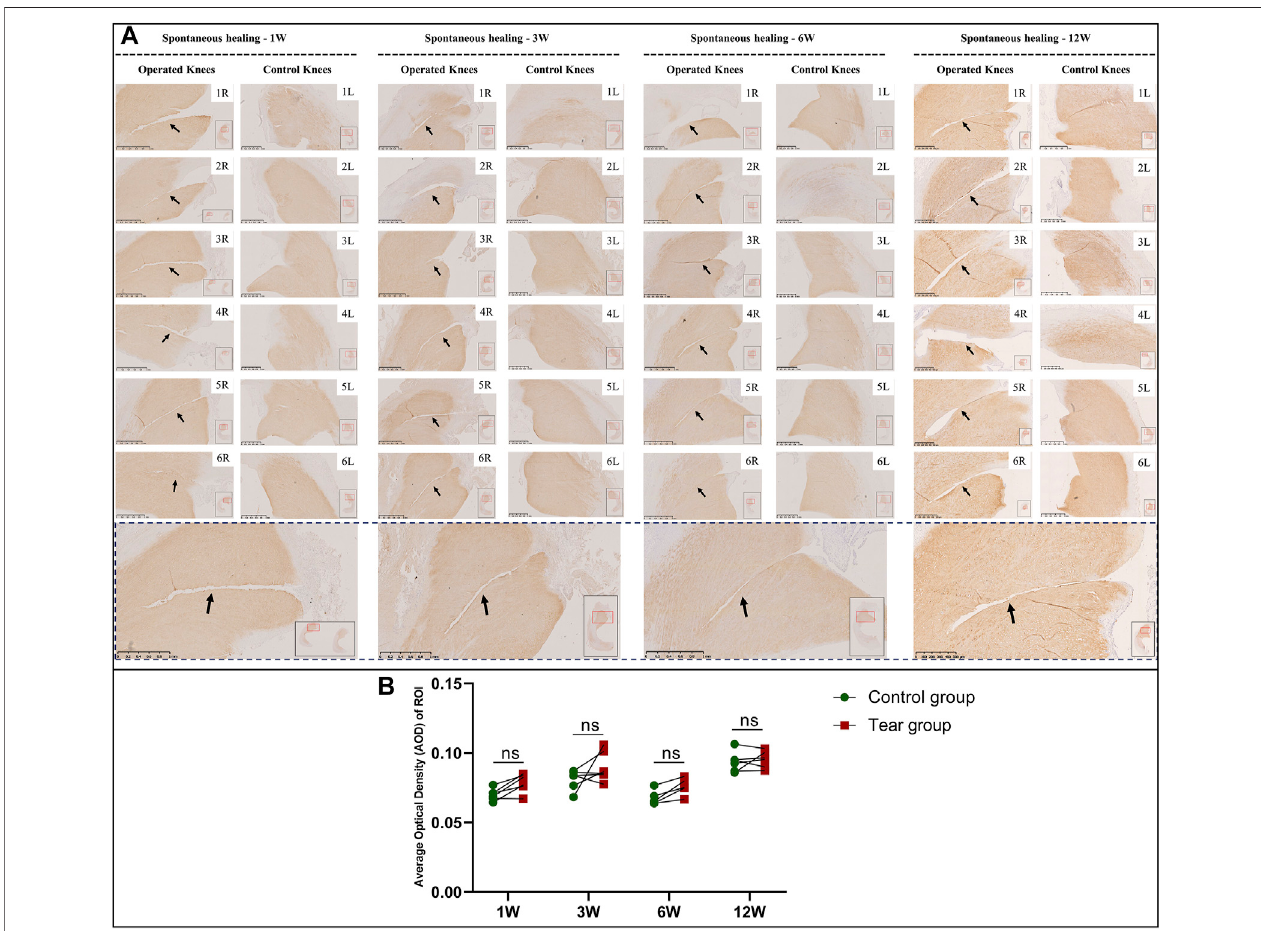
FIGURE 9 | Immunohistochemical and semiquantitative evaluation of type 2 collagen content in mature menisci. (A) Immunohistochemical staining of type 2 collagen. (B) Semiquantitative evaluation of type 2 collagen content. The black arrows indicate the tear site. The lower panel of images with a black dotted-line border indicate representative specimens in the corresponding observation period. AOD values are expressed as median values with 95% CIs. n (cid:1) 6.